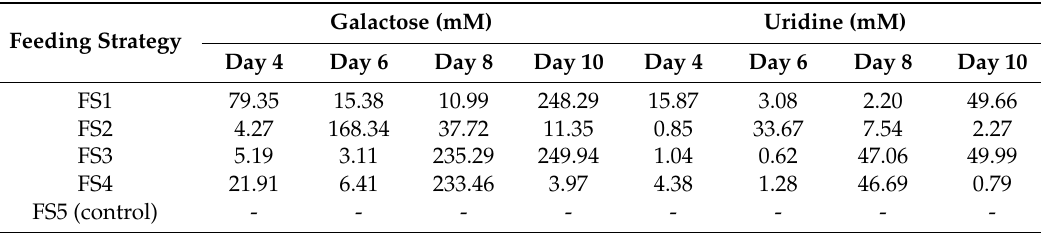
Table 1. Concentrations of galactose and uridine fed to the cell culture on different days for all the